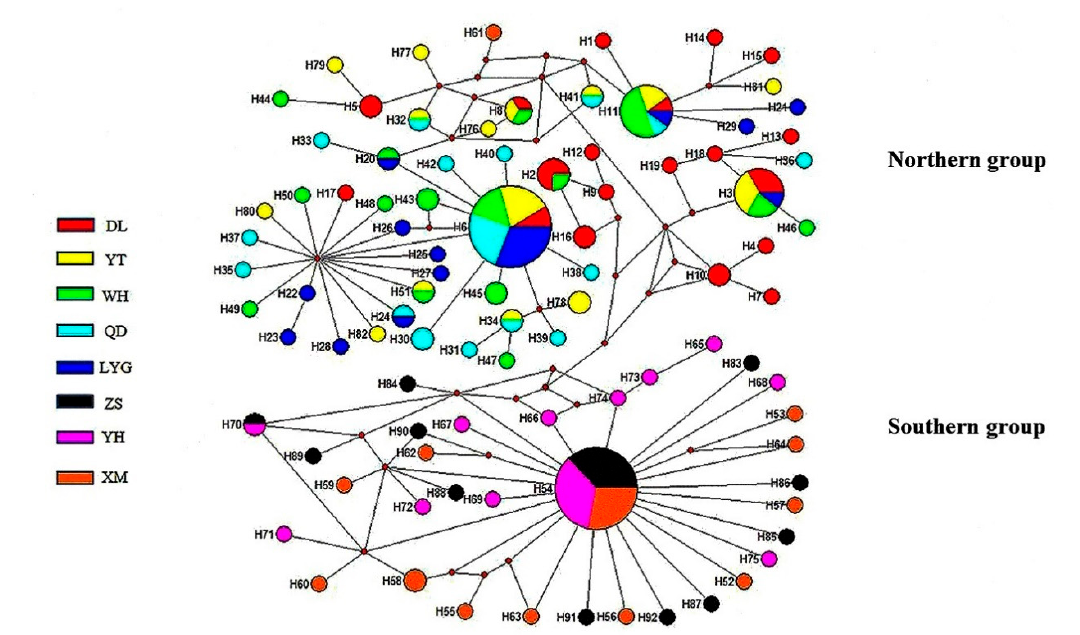
Figure 3. Median-joining haplotype network based on combined sequences of COI and 16S rRNA segments of A. rubrolineatus . Colors of localities correspond to those in Figure 1, and circle size is proportional to the number of individuals with the same haplotype. The distribution of all haplotypes was also given in Table S2.